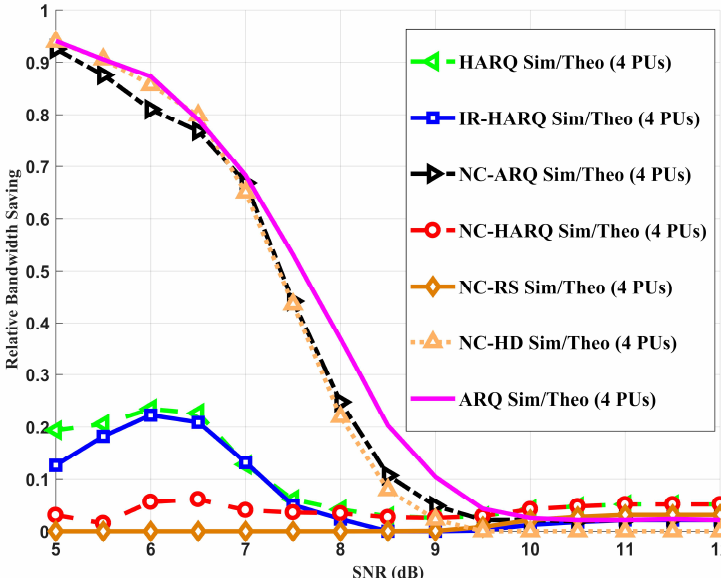
Figure 4. AC2NC relative bandwidth saving.